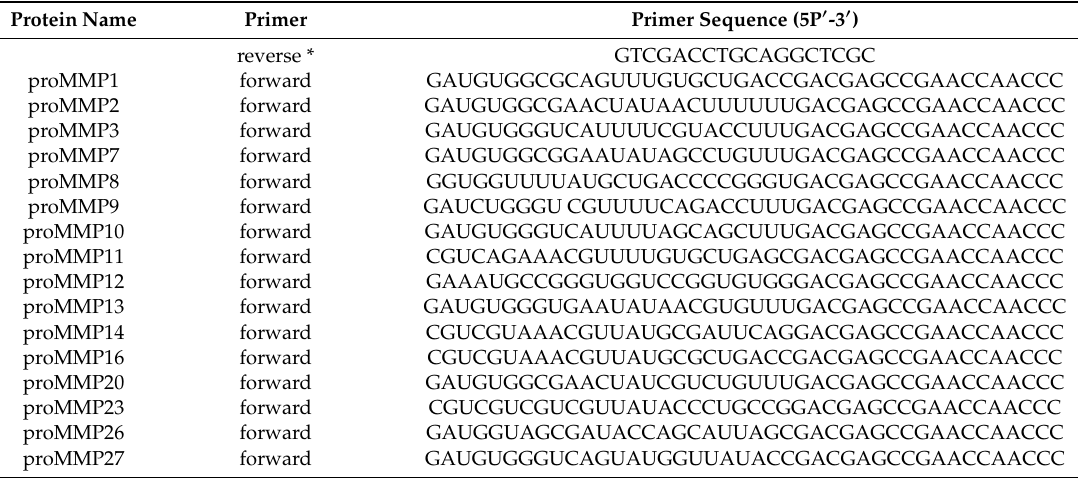
Table 4. Primers used for generating the proMMP CleavEx fusion proteins using